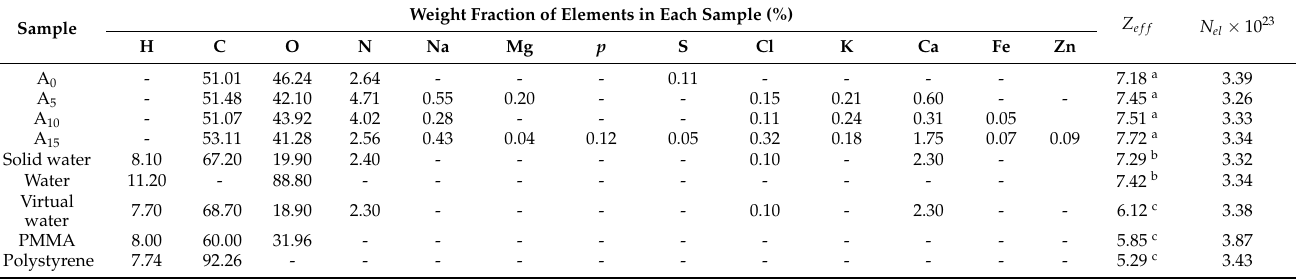
Table 2. Elemental compositions, Z ef f , and N el of phantom